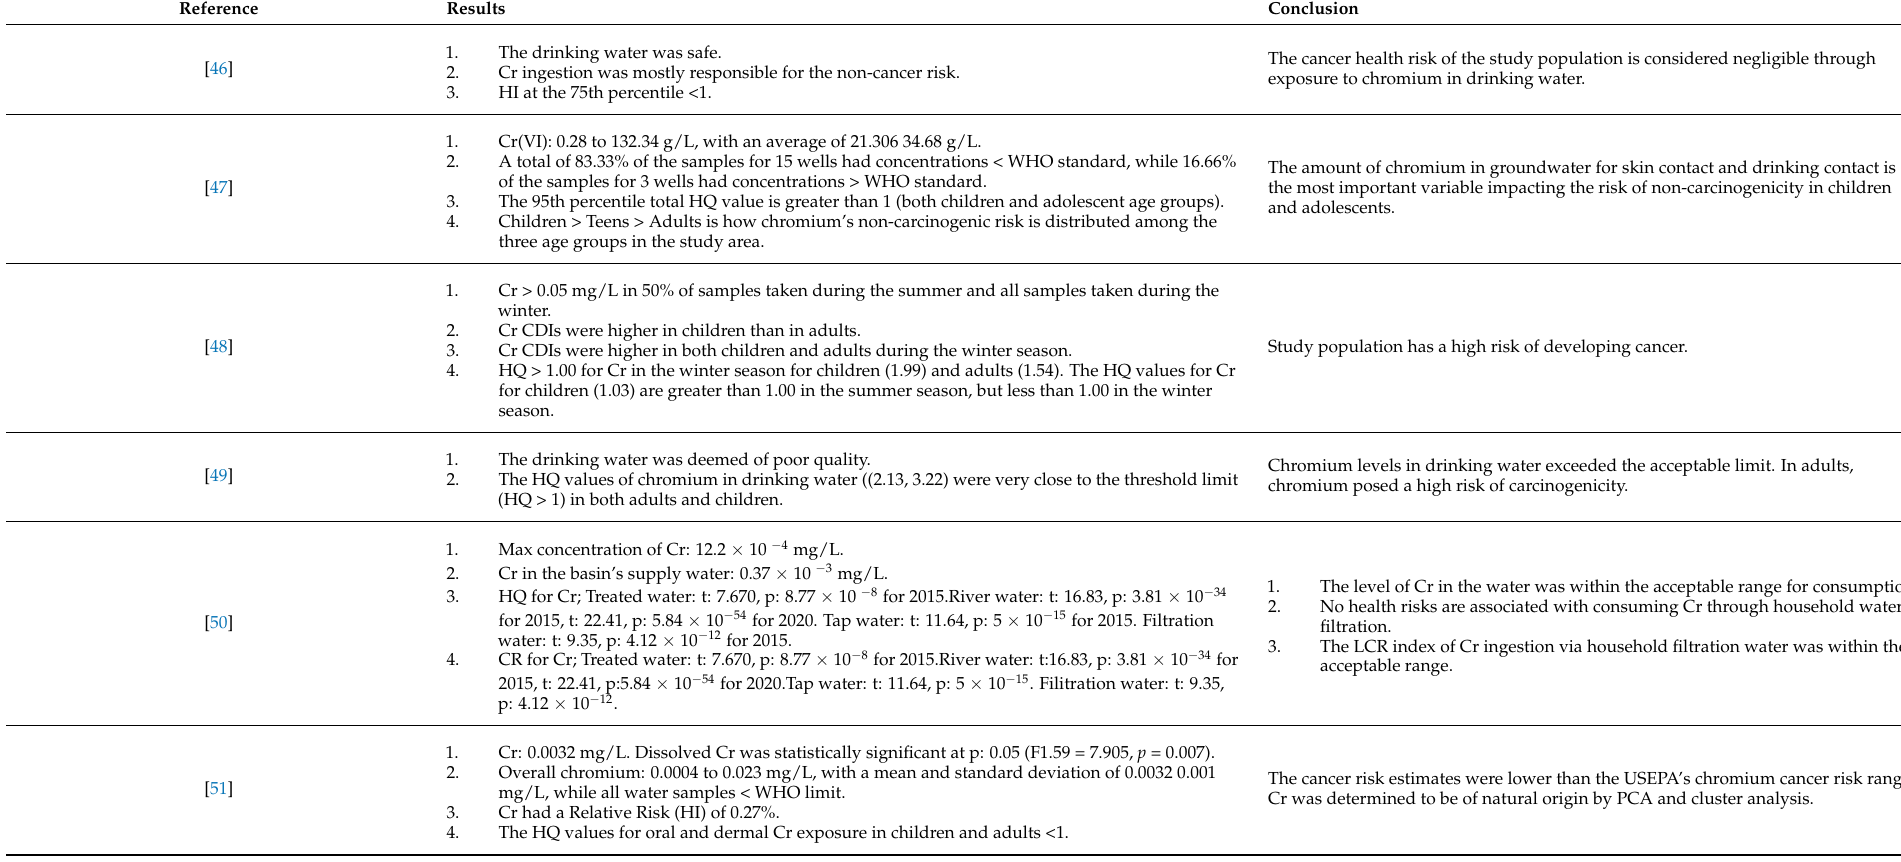
Table 7. Results and conclusions of the selected case studies included in the systematic